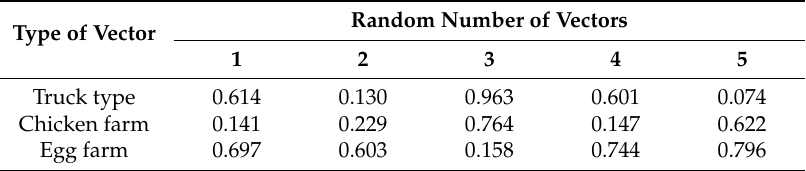
Table 12. Random number values for each vector.